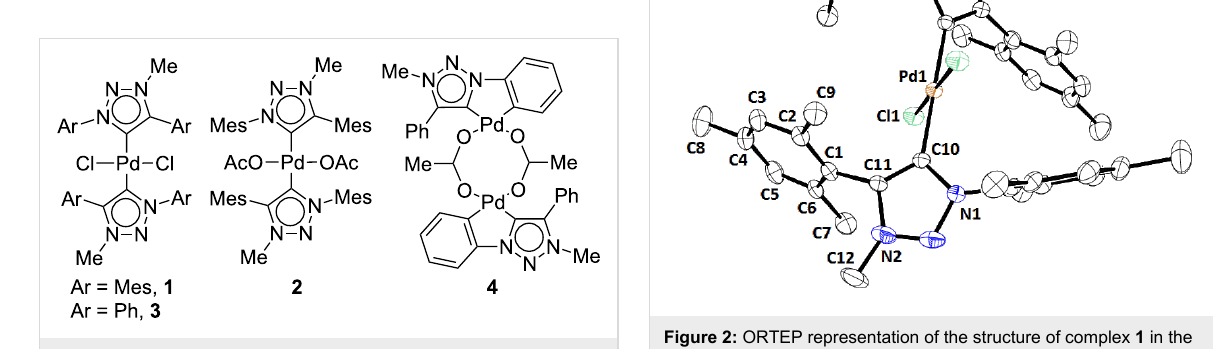
Figure 1: Structure of Pd complexes 1–4 .